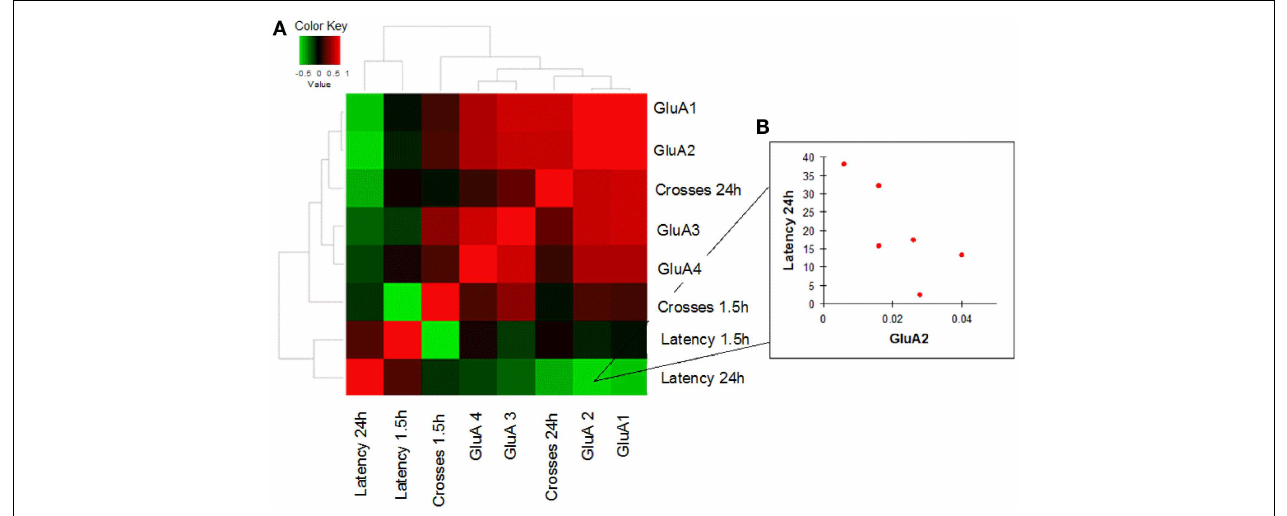
MWM parameters (latency and crosses) in youngWT mice. Direct and inverse correlations are shown in red and green, respectively. (B) WT mice showed an inverse correlation between GluA2 and MWM latency at